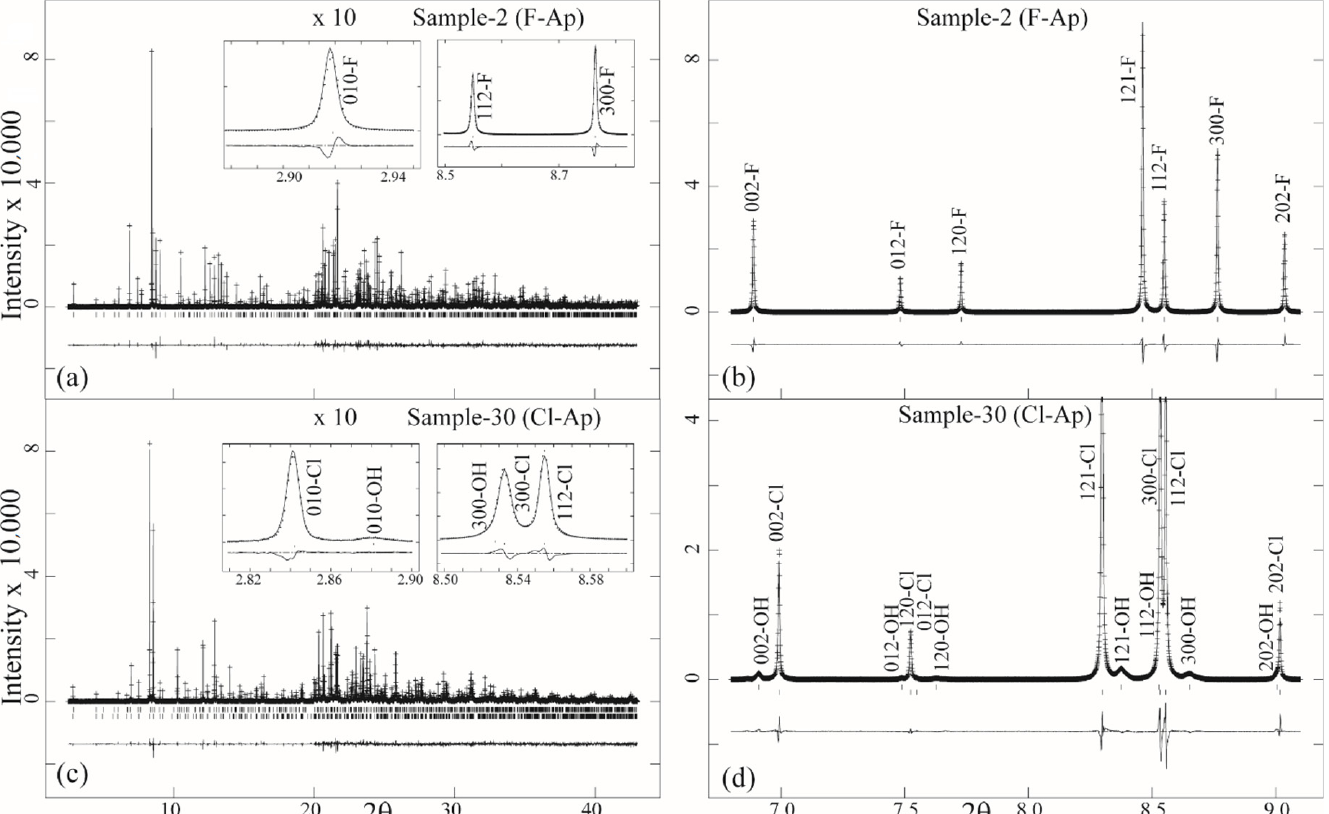
Figure 5. HRPXRD traces at 20 ◦ C together with the calculated (continuous line) and observed (crosses) profiles. The difference curve ( I obs − I calc ) with the same intensity scale is shown at the bottom of the trace. Short vertical lines indicate allowed reflection positions. The intensities for the trace and difference curve that are above 20 ◦ 2 θ are multiplied by 10. A single-phase F-Ap in sample-2 is shown where ( a ) contains the full trace with two inserts and ( b ) is an expanded part of the same ( a ) trace. For comparison, a two-phase Ap in sample-30 is shown in ( c , d ) that contains Cl-Ap (phase-30a) and OH-Ap (phase-30b). Inserts in ( a , c ) show an expanded area of the 010, 112, and 300 reflection peaks. Sample-30 contains an intergrowth of a Cl-Ap (92 wt.%) and a minor amount of OH-Ap (8 wt.%), as indicated in ( c , d ). The c axis is smallest in Cl-Ap, so some reflections switch positions when compared to